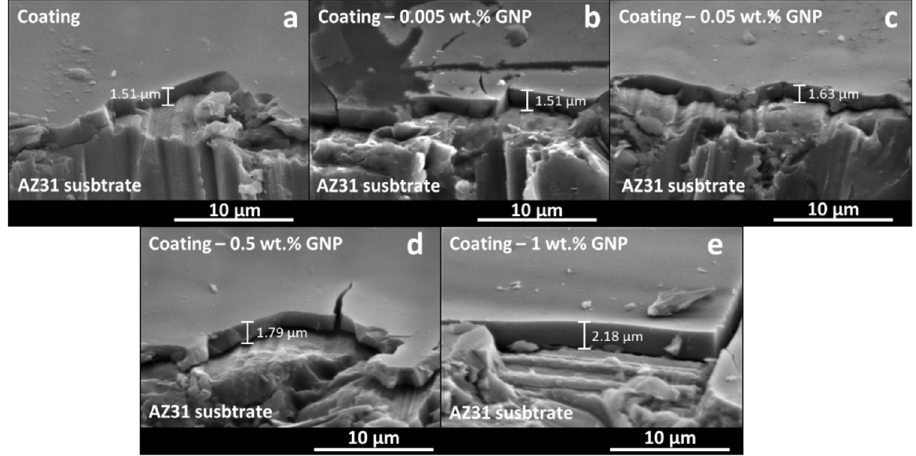
Figure 23. Adapted with permission from J.P. Fernández-Hernán et al. [113]. Copyright 2021 Elsevier. License number 5318820927306. Sol-gel coatings deposited on AZ31 alloy substrates. ( a ) Sol-gel without nanocharges, ( b ) Sol-gel + 0.005 wt.% COOH-GNPs, ( c ) Sol-gel + 0.05 wt.% COOH-GNPs, ( d ) Sol-gel + 0.5 wt.% COOH-GNPs, and ( e ) Sol-gel + 1 wt.% COOH-GNPs.